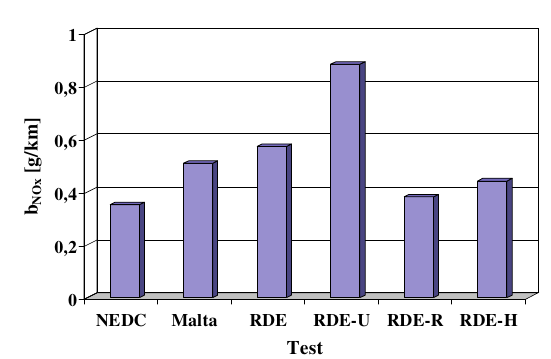
Fig. 10. Mean nitrogen oxides road emissions – b NOx in each of the test cycles